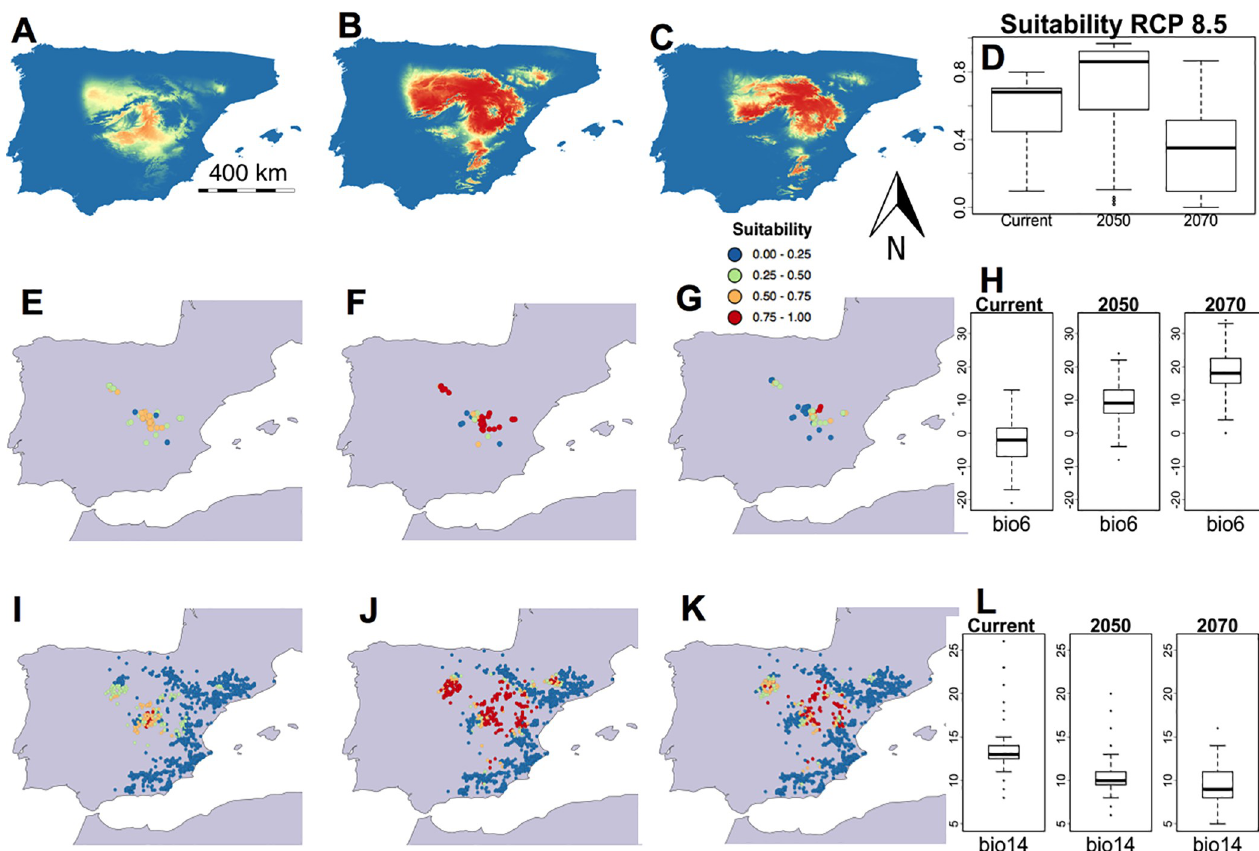
Fig 5. Habitat suitability predicted by the MaxEnt models for G . bermejoi under the RCP 8.5 scenario. Habitat suitability map for the current climatic conditions (A), and under those predicted for 2050 (B) and 2070 (C). (D) Habitat suitability values (R software standard box-plot) in the current climatic conditions, and under those predicted for 2050 and 2070 measured at the sites where the taxon is currently found. In E, F and G, we show the bioclimatic suitability values taken at the sites where G . bermejoi is currently found. A color code was used to express the different intervals of habitat suitability. (H) These box-plots show the evolution of the Bio 6 variable (minimum temperature in the coldest month) measured at the sites where G . bermejoi is currently found. The bioclimatic suitability was also measured at each location for gypsum soils indicated by the presence of O . tridentata . These values are shown in maps I, J and K, for the current climatic conditions, and under the conditions predicted for 2050 and 2070, respectively. (L) These box-plots are similar to those in (H) but for the Bio 14 variable (precipitation in the driest month), also measured at the locations where G . bermejoi is currently found.